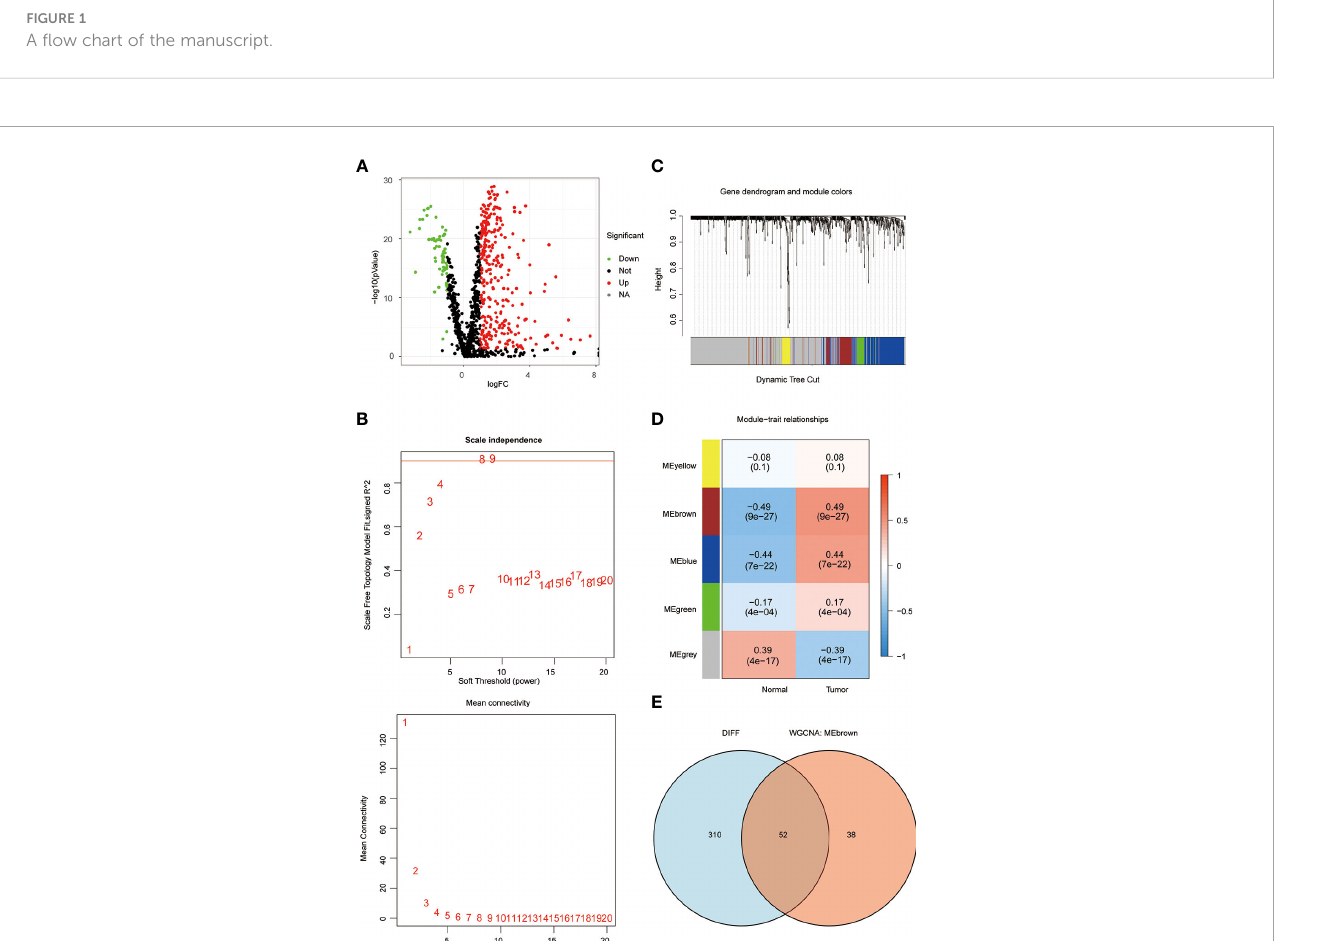
FIGURE 1 A fl ow chart of the manuscript.